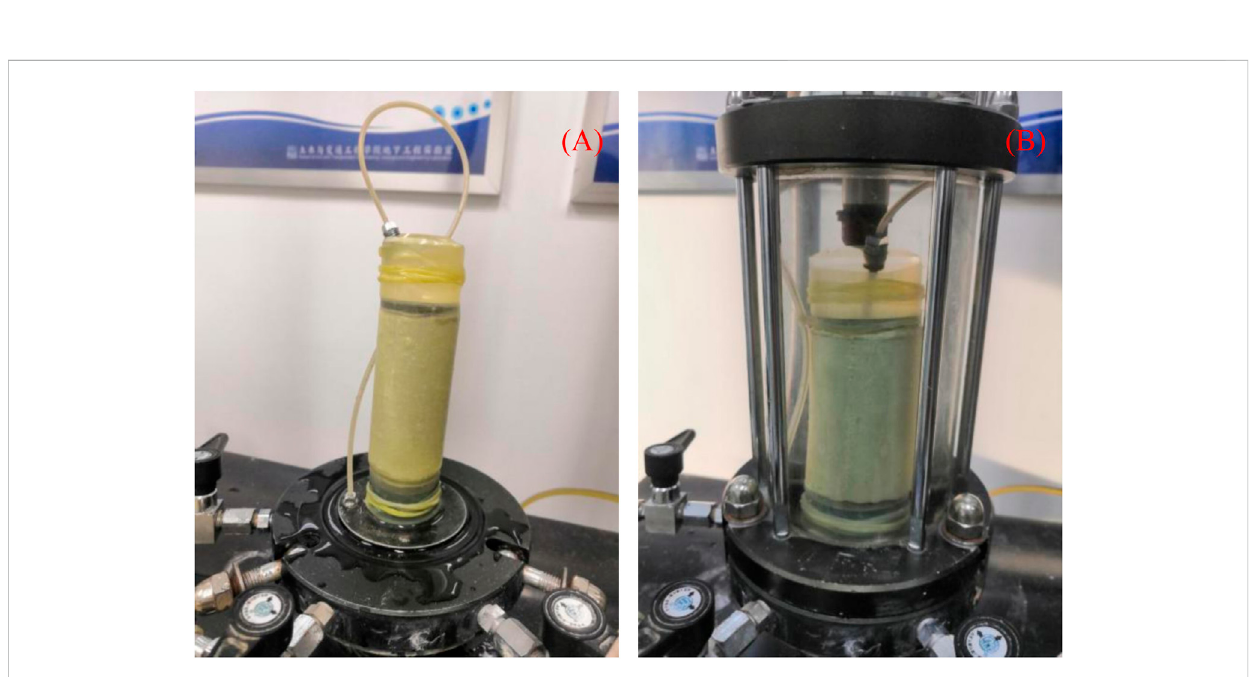
FIGURE 5 Specimen mounting of triaxial shear test. (A) Specimen loaded into rubber membrane and (B) specimen loaded into pressure chamber cover and fi lled with